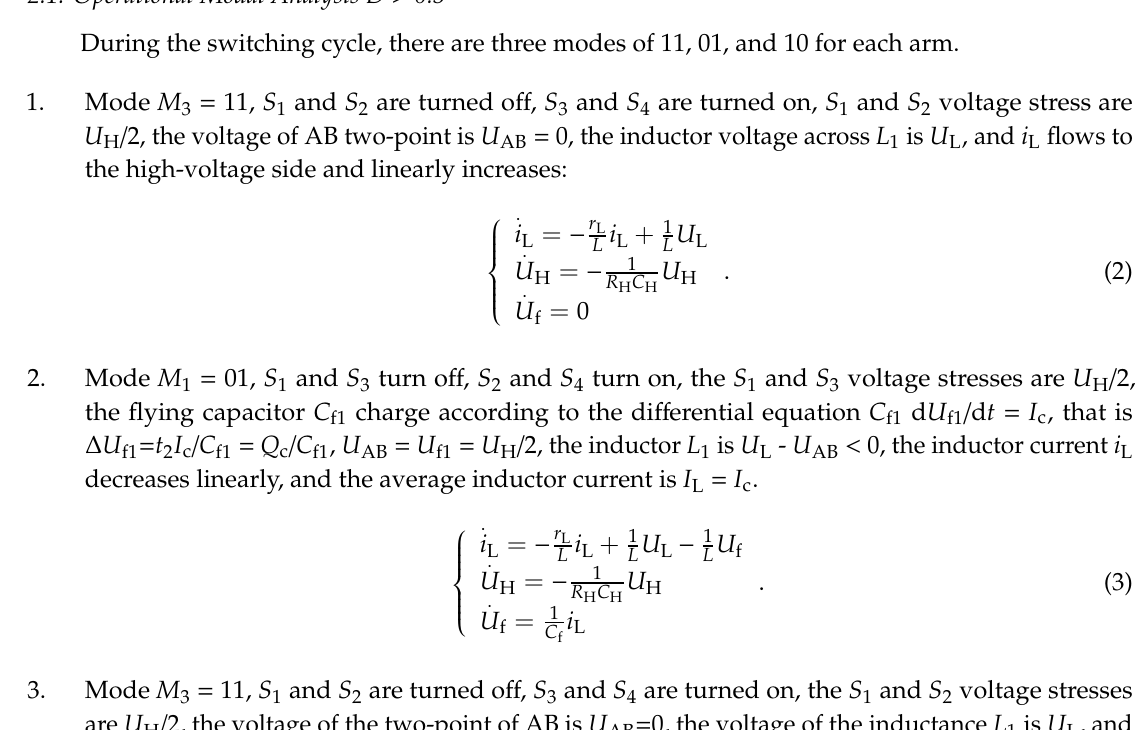
Figure 2. The main waveform of the basic unit. (a) Mode D > 0.5. ( b ) Mode D < 0.5.